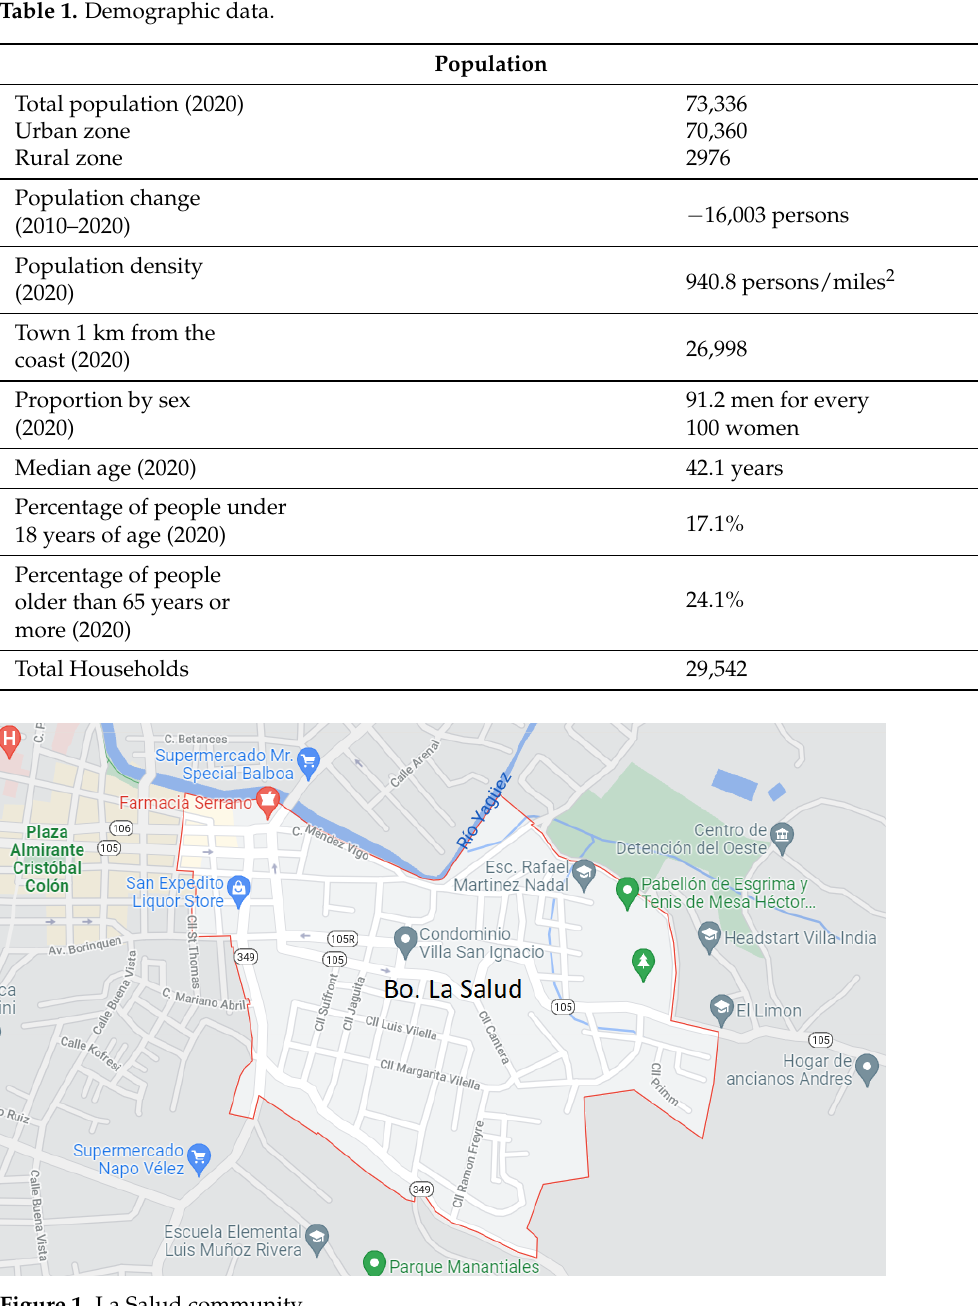
Table 1. Demographic data.